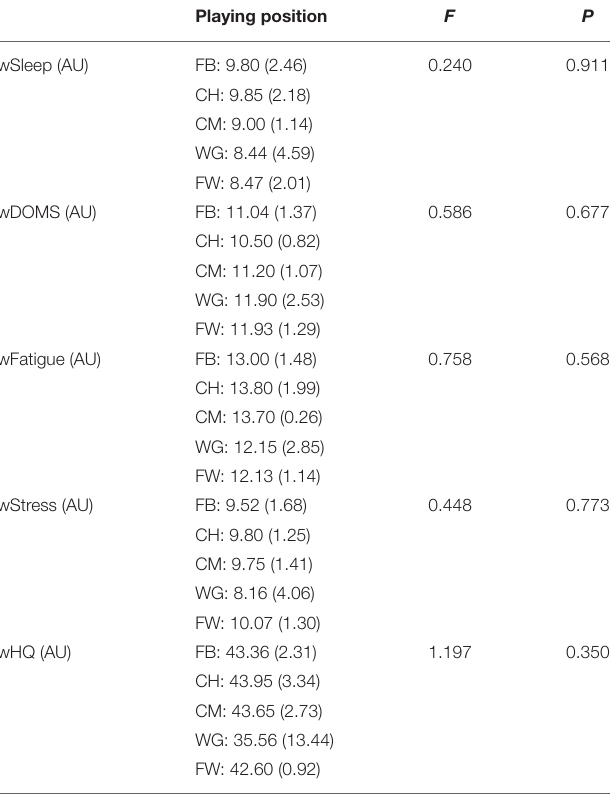
TABLE 5 | Outcomes of ANOVA for well-being variables during end-season, considering playing positions. Playing position